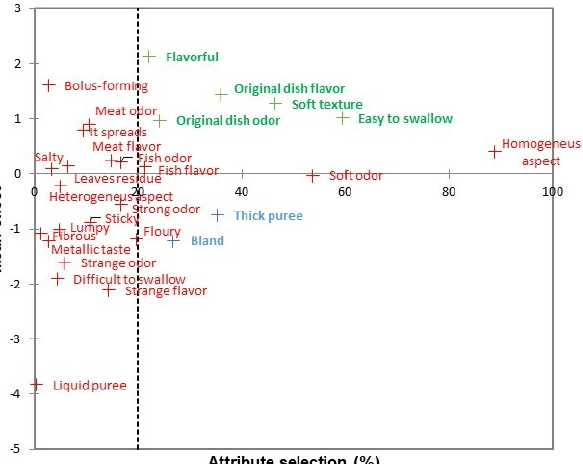
Figure 4. Effects on the mean and the percentage of attributes in the judges’ hedonic evaluations about the texture-modified dishes. Blue words signify “must not have” attributes, and green words identify those that are “nice to have” with significant effect ( p < 0.05) on the mean.